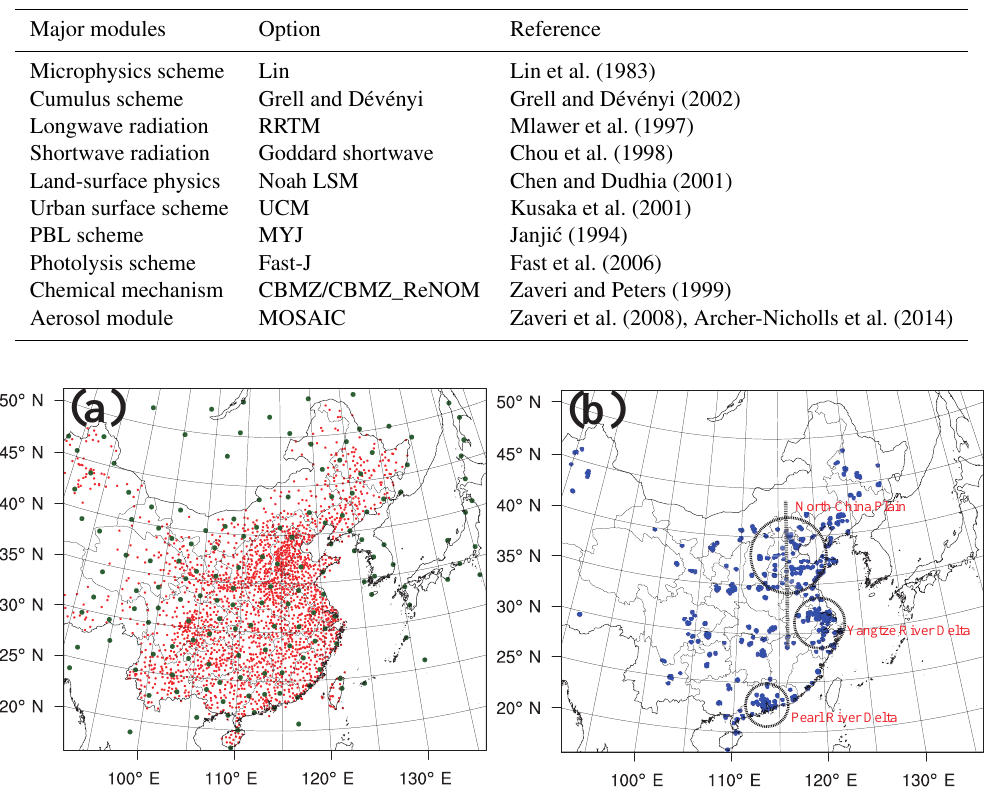
Figure 1. WRF-Chem domain used in this study. (a) Red dots denote the surface weather stations used in FDDA (3-hourly); green dots are the sounding sites (12-hourly). (b) Blue dots denote the available surface air quality monitoring stations operated by China MEP in 2014, and the dashed line represents the vertical domain that intercepts the very polluted North China Plain.